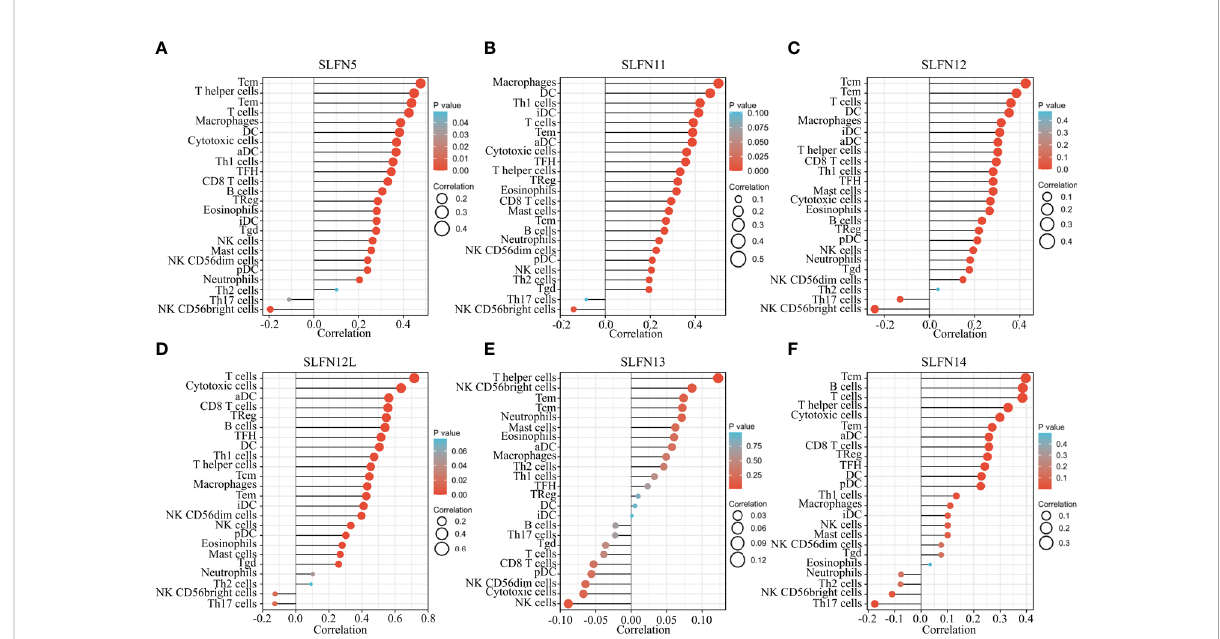
FIGURE 7 Relationship between SLFN family members and tumor immune cell in fi ltration. (A – F) The relationship between SLFN family members and immune cell in fi ltration in gastric cancer was analyzed using TCGA database. (A, C, D) SLFN5, SLFN12, and SLFN12L were mainly related to T cell in fi ltration, especially Tcm cell in fi ltration. (B) SLFN11 was mainly associated with macrophages and DC cells. (E) SLFN13 had no signi fi cant relationship with tumor immune cell in fi ltration. (F) SLFN14 was associated with Tcm and B cell in fi ltration.